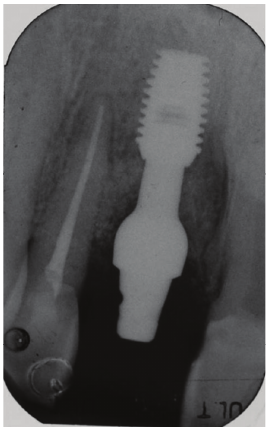
Figure 22: Radiograph showing the long abutment post, chosen to respect the bone and mucosal tunnel.